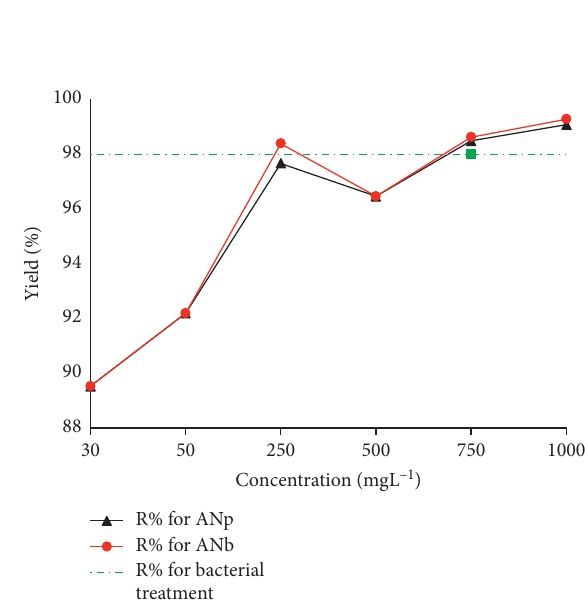
Figure 14: Cross between color removal (%) of MR onto raw (ANb) and purified (ANp) clays and the bacterial